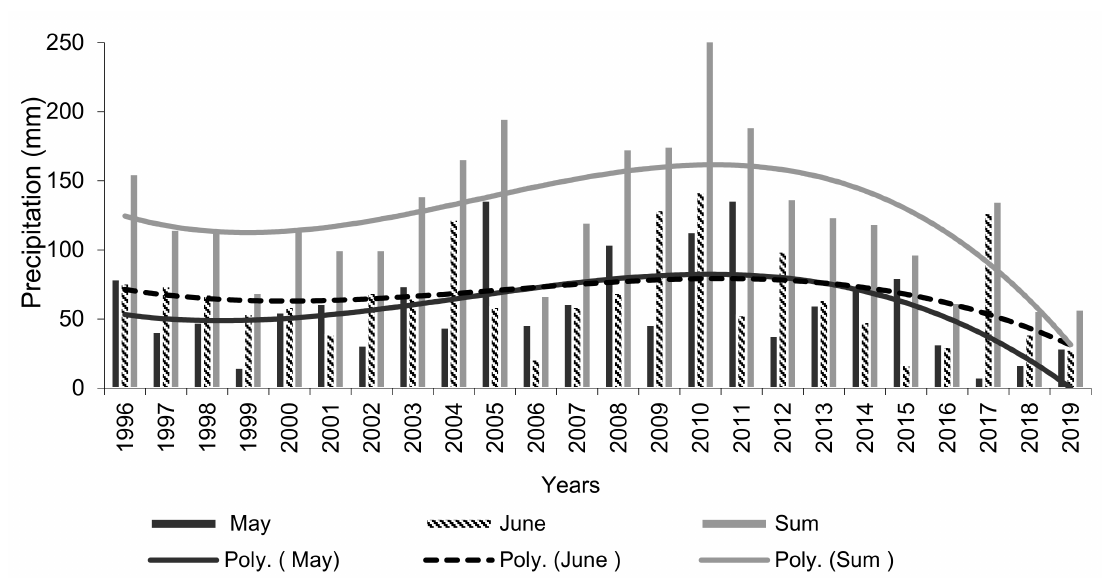
Figure 1. Monthly rainfall in May and June and sum in May and June between 1996 and 2019 in Voke and the regression line between 1996 and